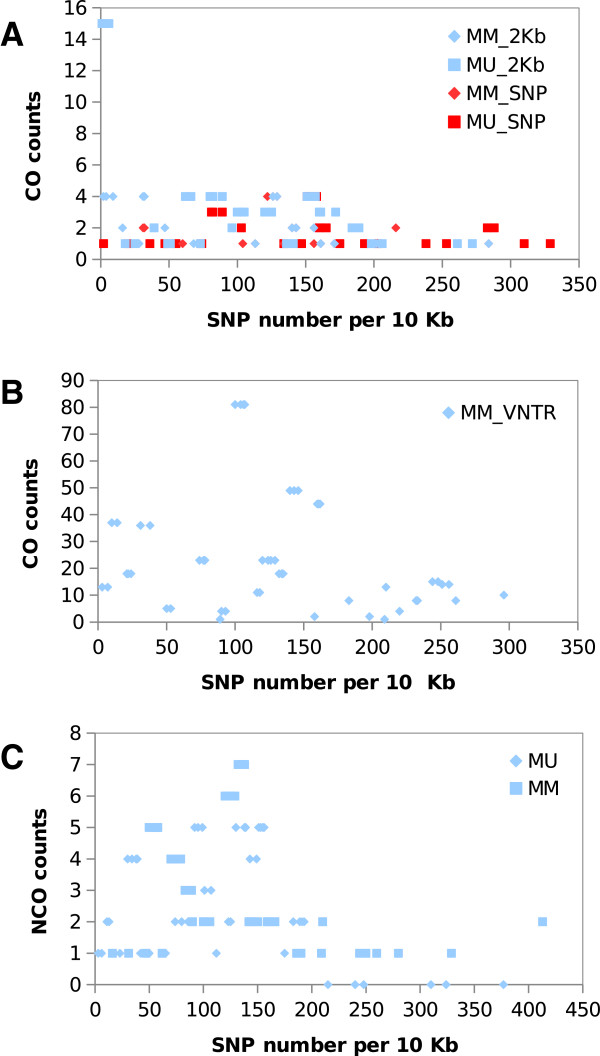
Distribution of recombination events among regions of different SNP densities. Recombination events in the recombinant clones show a negative correlation with SNP densities. (A) COs found in our study. (B) COs identified by VNTR typing and reported by Katzer F. et al. [10]. (C) NCOs found in our study. MM_SNP: SNP typing of MugugaMarikebuni. MU_SNP: SNP typing of MugugaUganda. MM_VNTR: VNTR typing results of MugugaMarikebuni.